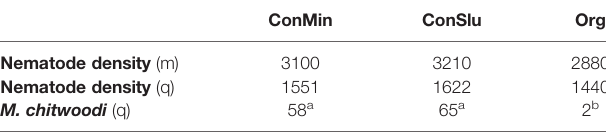
TABLE 3 | Mean nematode densities and M. chitwoodi abundances (individuals per 100g soil) in the pea fi elds with three distinct soil management regimes.